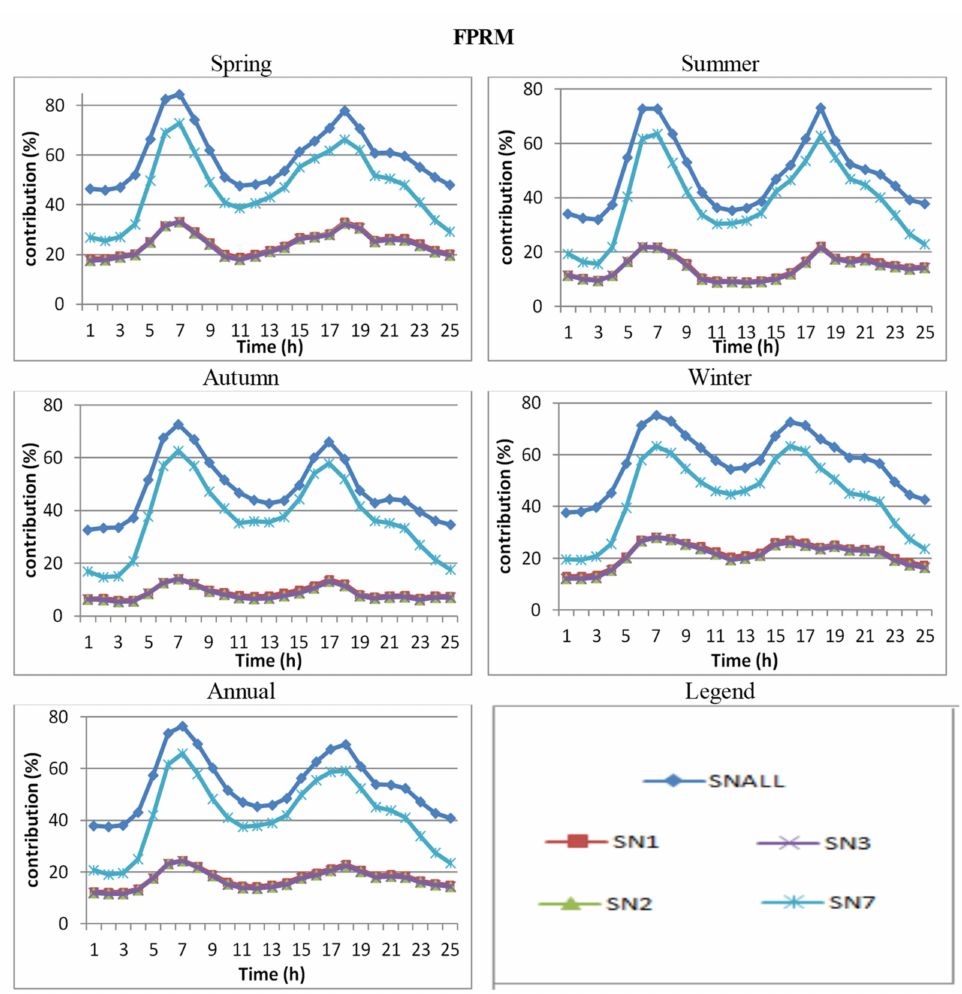
Figure 12. Annual and seasonal averaged relative contribution (%) of all emissions and the emissions from different SNAP categories of the formation of FPRM concentrations for Orlov most for the period